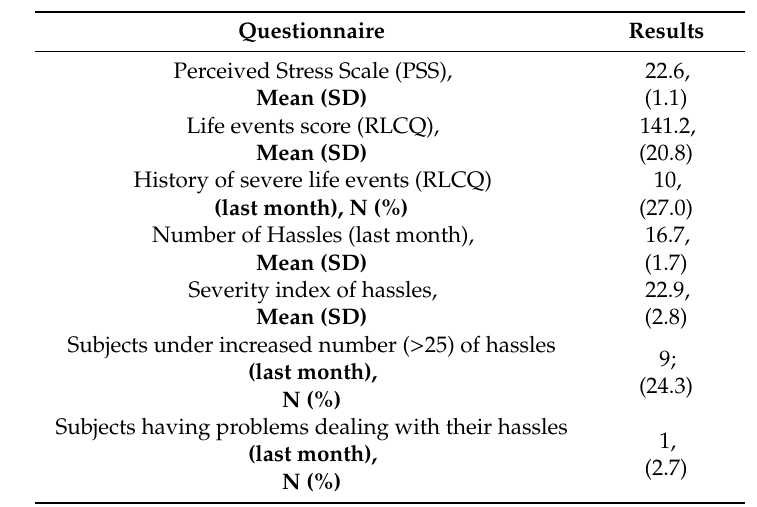
Table 3. Self-Administrated